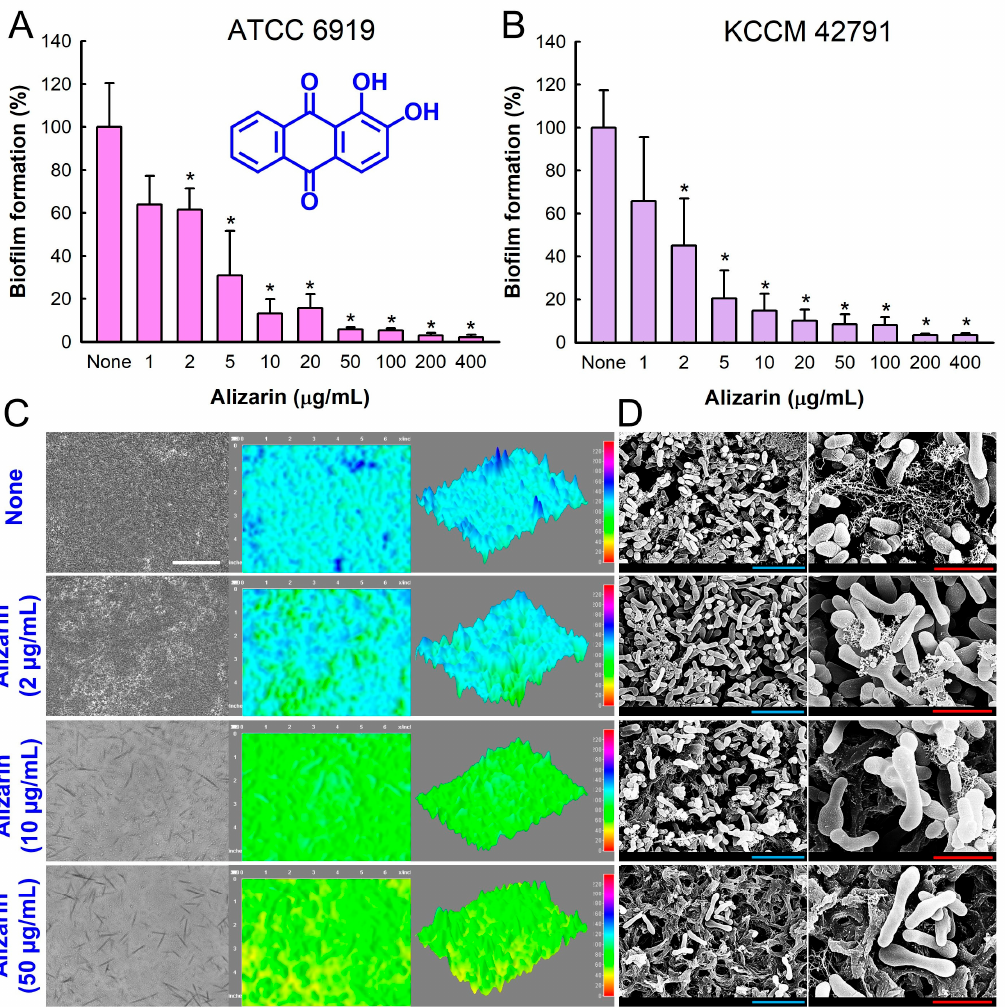
Figure 1. Alizarin inhibited biofilm formation by C. acnes . The antibiofilm activity of alizarin on C. acnes ATCC 6919 ( A ) and KCCM 42791 ( B ) was investigated in 96-well polystyrene plates for 7 days under anaerobic conditions. Chemical structure of alizarin is shown. ( A ) Regenerated C. acnes ATCC 6919 biofilm color-coded 2D and 3D images after culture with alizarin. ( C ) SEM images of C. acnes ATCC 6919 biofilms developed in the presence or absence of alizarin. ( D ) White, blue, and red scale bars indicate 100, 5, and 2 µm, respectively. None: non-treated control. Error bars represent standard deviations. * p < 0.05 vs. non-treated controls.